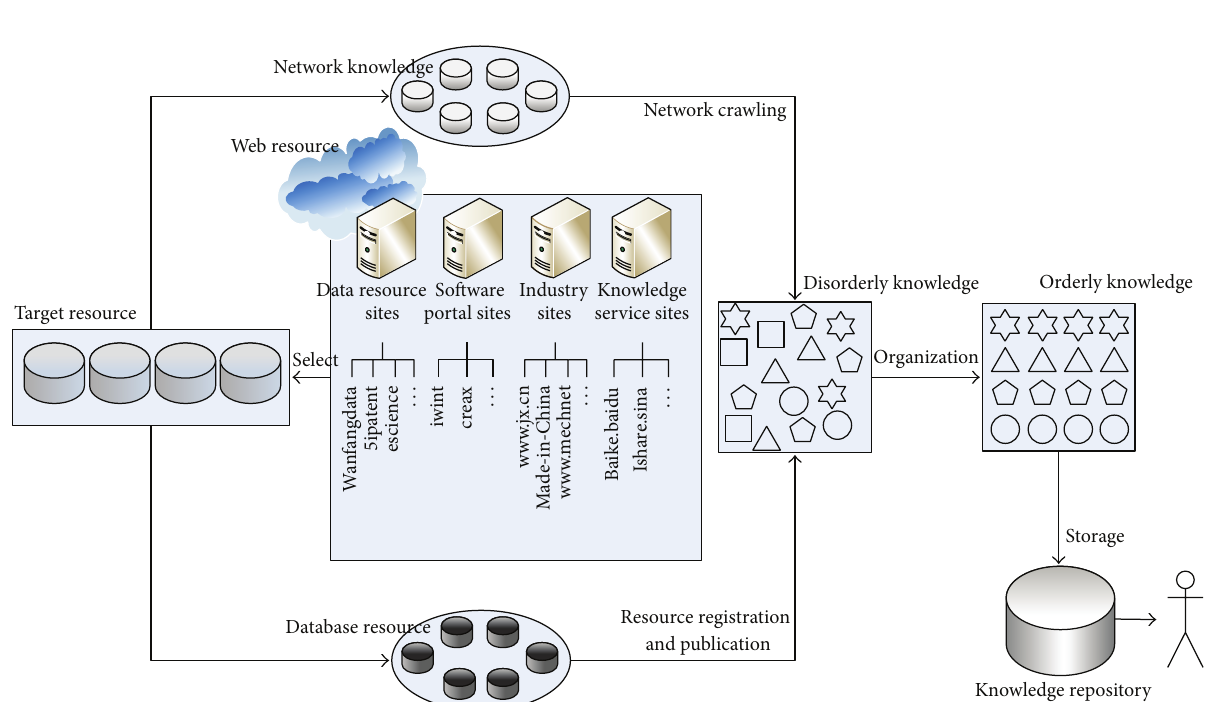
Figure 4: The acquisition process of knowledge resources online.